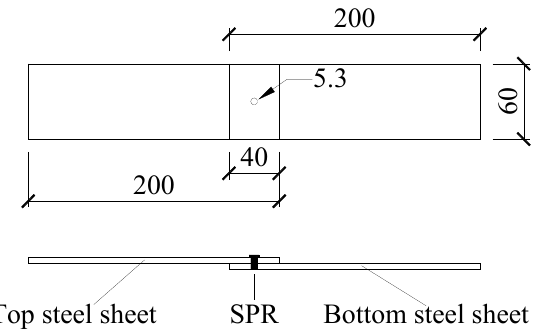
Figure 2. The specimens for the CFS-SPR connection (mm).